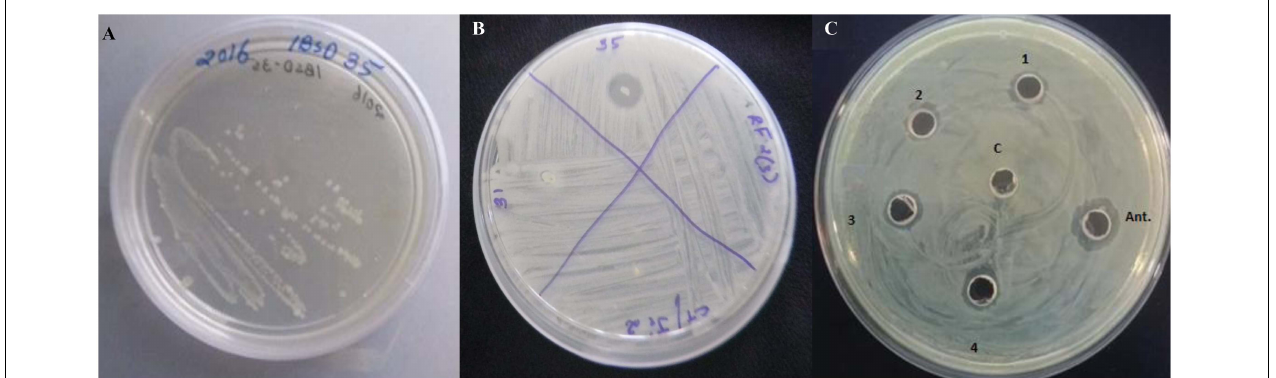
FIGURE 2 | (A) A pure colony streak of Paenibacillus peoriae IBSD35 on LB agar, (B) Preliminary antimicrobial susceptibility test of the endophyte strains against S. aureus ATCC 25923 (P. peoriae IBSD35, strain IBSD31, strain IBSD21, and strain IBSD 22), (C) retention of antimicrobial activity at different stages of purification against S. aureus ATCC 25923 using a cut agar well diffusion bioassay (1, crude; 2, ammonium sulfate precipitate; 3, DEAE-C; 4, RP-HPLC; C, control (LB medium); and Ant., is peptide antibiotics, nisin).